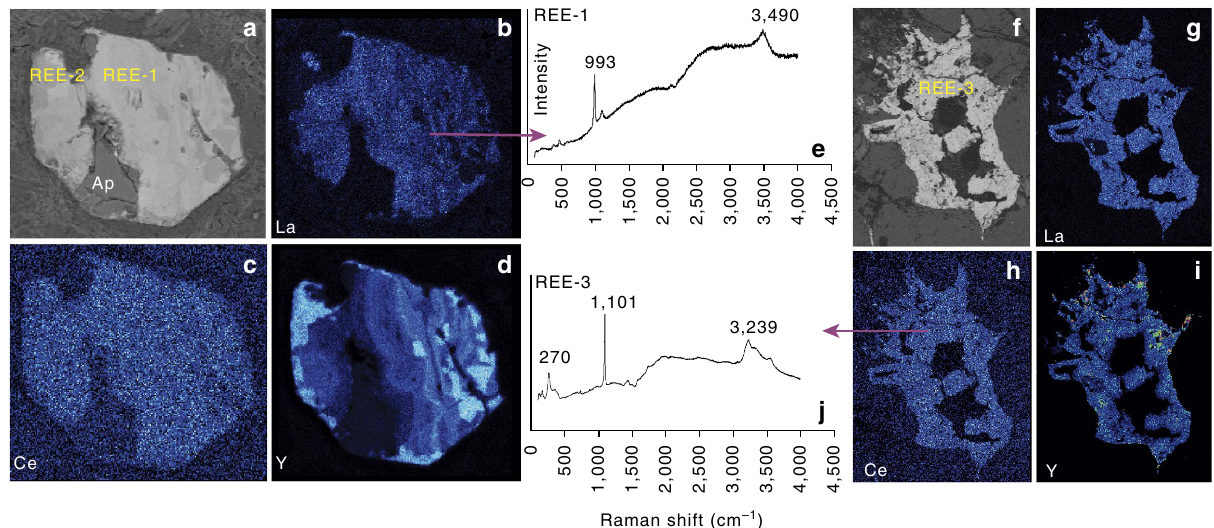
Figure 3 | REE compositional maps and Raman spectroscopic analyses of altered fluorapatite and REE fluorcarbonates. ( a – e ) REE phosphates (REE-1 and REE-2); ( f – j ) REE fluorcarbonates (REE-3). ( a , f ) backscattered-electron images (field of view: 60 and 350 m m, respectively). ( b – d , g – i ) X-ray distribution maps of La, Ce and Y. ( e , j ) Raman spectroscopic data showing the occurrence of water in the mineral structure (3,490cm (cid:2) 1 and 3,239cm (cid:2) 1 for REE-1, REE-3, respectively).